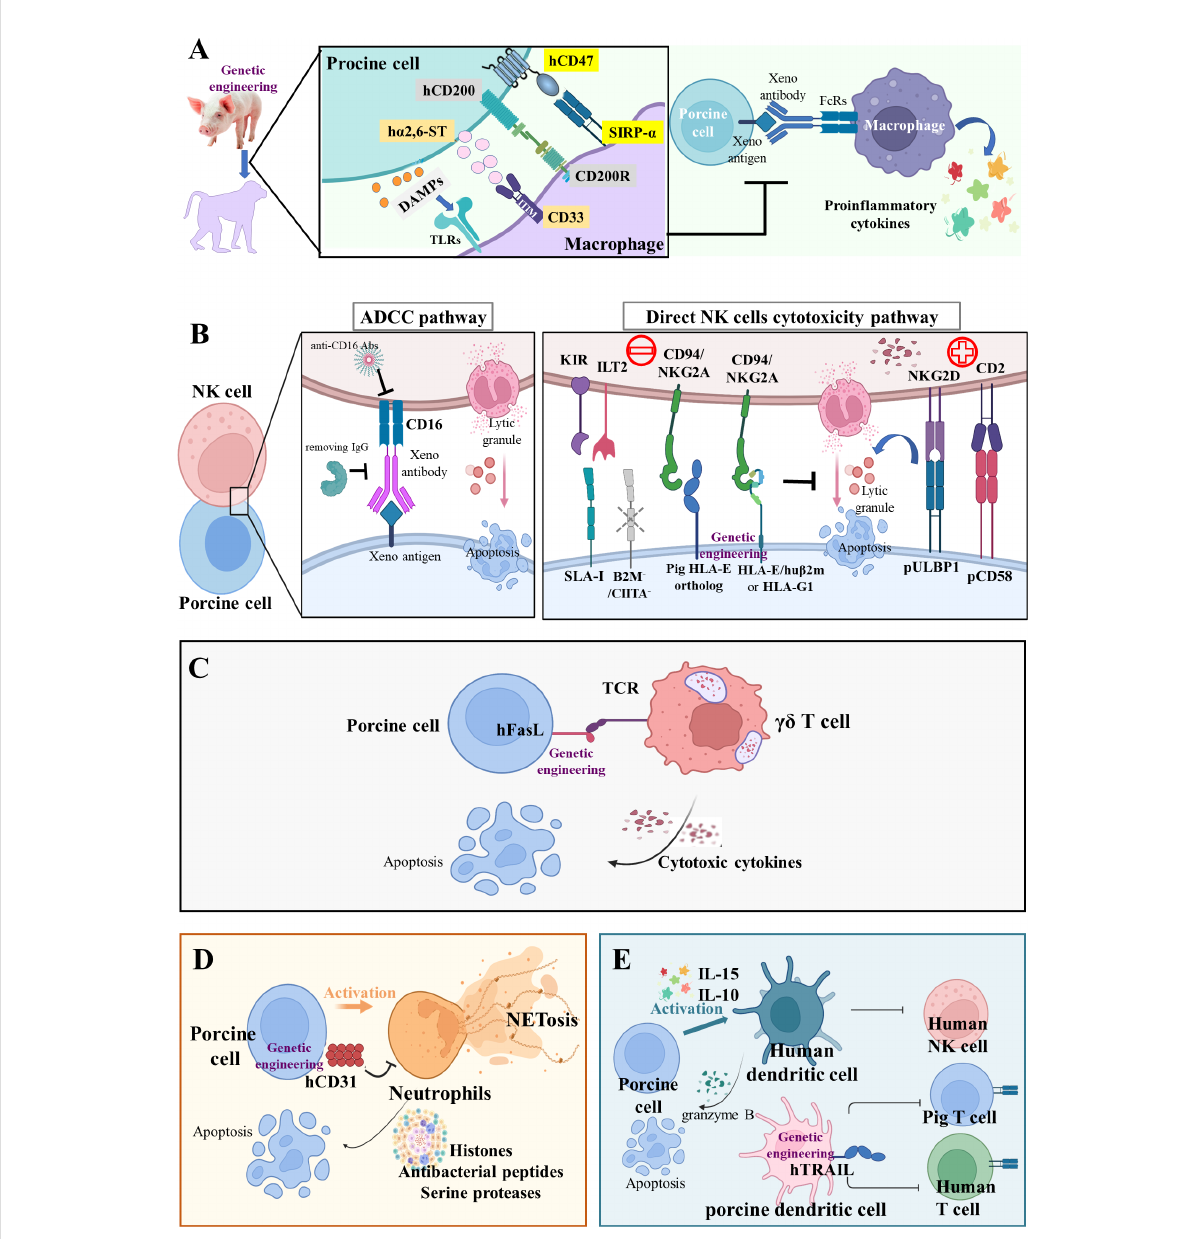
FIGURE 2 Innate cellular xenograft rejection (A) Macrophage-mediated rejection. Macrophages mediate robust rejection of donor hematopoietic cells in a variety of xenogeneic settings; this potent xenoreactivity results from the combined effects of CD47-SIRP a inhibitory receptor signaling, CD200-CD200R signaling, CD33-Siglecs signaling, and DAMPs from damaged porcine cells. The relevant genetic modi fi cations of macrophage-mediated rejection are hCD47 , hCD200 , and h a 2,6-ST transgenes. (B) NK-cell-mediated rejection. NK cells may induce pig endothelium lysis via two main immune mechanisms of antibody-dependent cytotoxicity (ADCC) and direct NK cell cytotoxicity. During ADCC, the NK cells recognize and bind to the Fc region of antibody deposits through their CD16 and then release cytotoxic granules. In the direct NK cells ’ cytotoxicity pathway, the inhibitory receptors on human NK cells, including KIR, ILT2, and CD94/NKG2A, poorly recognize the SLA-I and pig HLA-E ortholog, thus disabling inhibitory signals for NK cell activation. In addition, the upregulation of pULBP1-NKG2D and pCD58-CD2 activating signals could lead to direct NK cell cytotoxicity. The relevant genetic modi fi cations of NK-mediated rejection are HLA-E/hB2M transgene and B2M -/- / CIITA -/- knockout. (C) Innate-like T cell-mediated rejection. The gd T cells trigger rapid immune responses and are cytotoxic for porcine endothelial target cells. The strategies of hFasL transgene targeted at these innate-like T cells may reduce their cytotoxicity. (D) Neutrophil-mediated rejection. The hCD31 transgene on porcine endothelial cells can suppress neutrophil-mediated xenogenic cytotoxicity via the inhibition of NETosis (histones, antibacterial peptides, and serine proteases). (E) DC-mediated rejection. In fl ammatory cytokines-activated human DC is cytotoxic to porcine aortic endothelial cells by controlling human NK cell responses and pig CD8 + T lymphocytes. The hTRAIL transgene on pig DCs can decrease human T cell